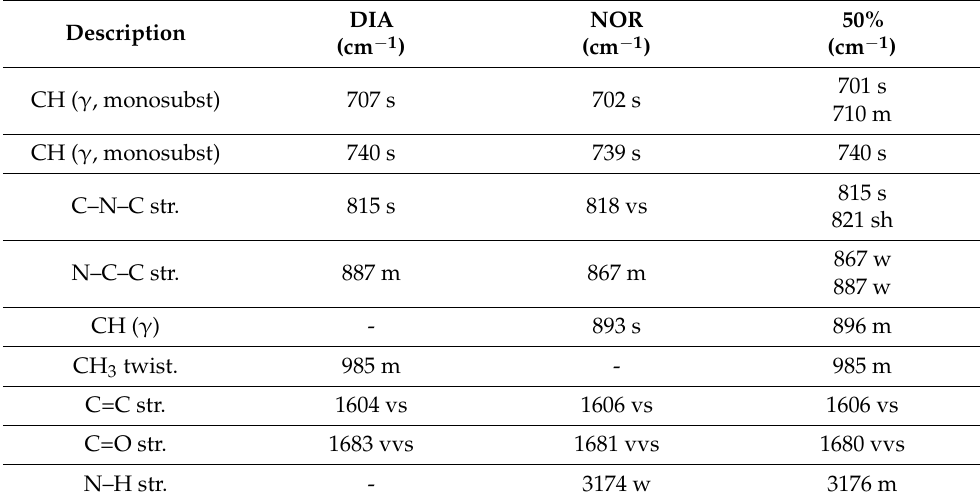
Figure 6. ( a ) Global FTIR spectra of the poly ‐ crystalline DIA and NOR powders and their 50% binary mixture in the glass (amorphous solid) state. ( b , c , d ) Zoom of the spectra of panel ( a ) in the spectral region of the C=O vibration (carbonyl group, b), C–N modes, and C–H vibrations of the chlorobenzene ring, respectively. Inset to ( b ): detail of the spectra in the region of the (hydrogen- bonded) N–H stretching. Table 2. Wavenumbers (cm − 1 ) of selected bands in the IR spectra of DIA, NOR, and their equimolar amorphous binary mixture. The assignment of bands is based on Ref.